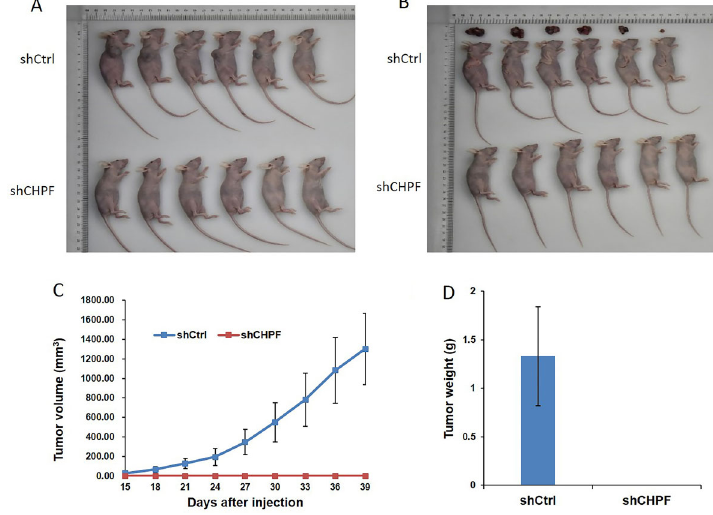
Figure 6. Effect of chondroitin polymerizing factor ( CHPF ) on tumorigenicity in nude mice. A , Equal numbers of CHPF silenced (sh CHPF ) or control A549 cells were subcutaneously administered to nude mice. B , Excised tumors were recorded. The volume ( C ) and weight ( D ) of tumors were measured (n=6). Data are reported as means ±